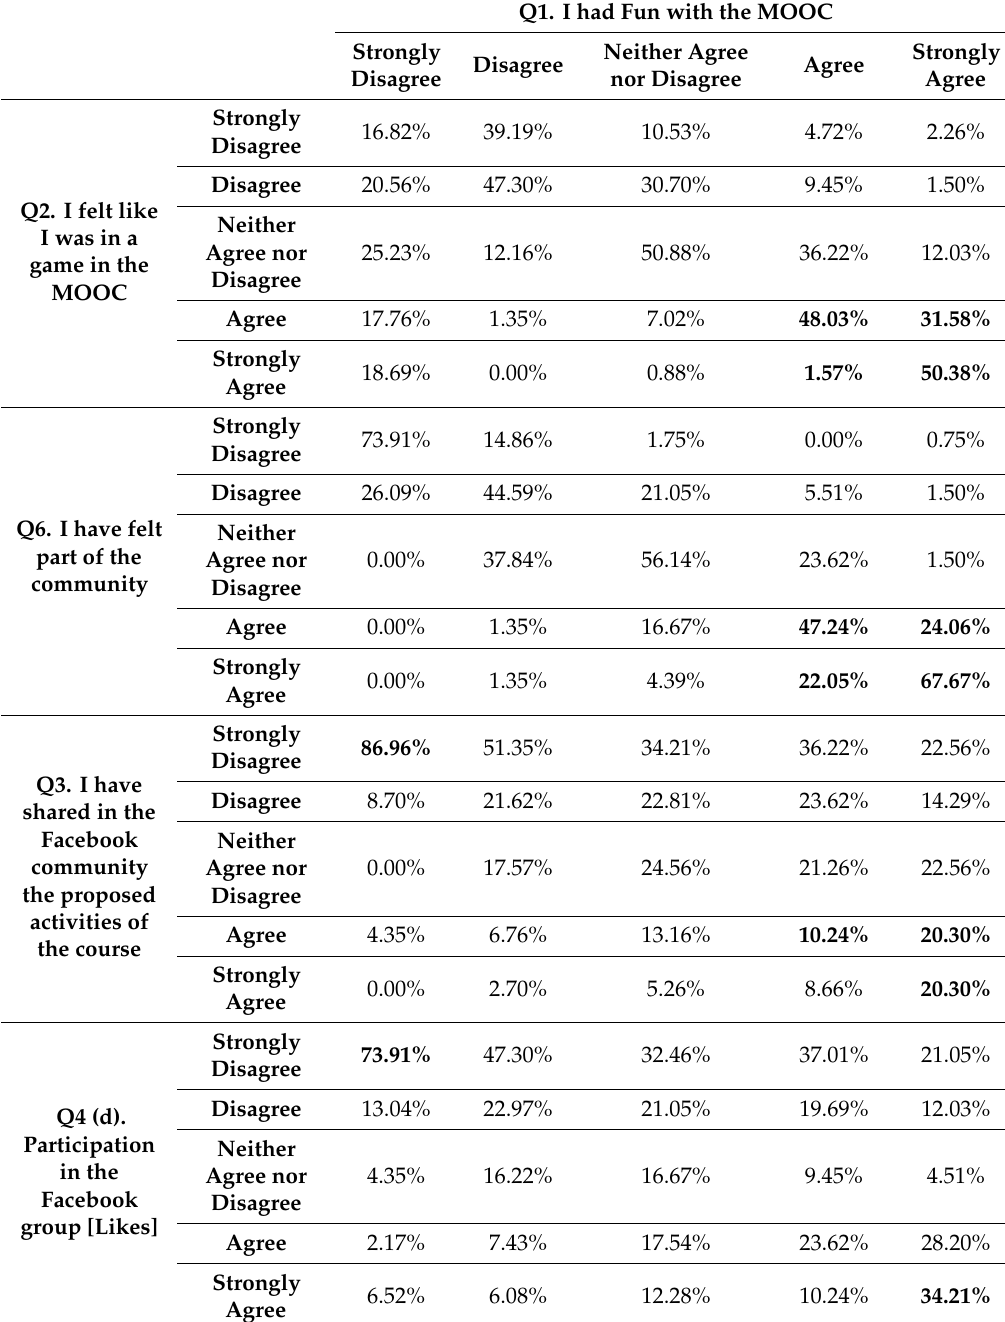
Table 5. Relationship between gamification, community engagement and